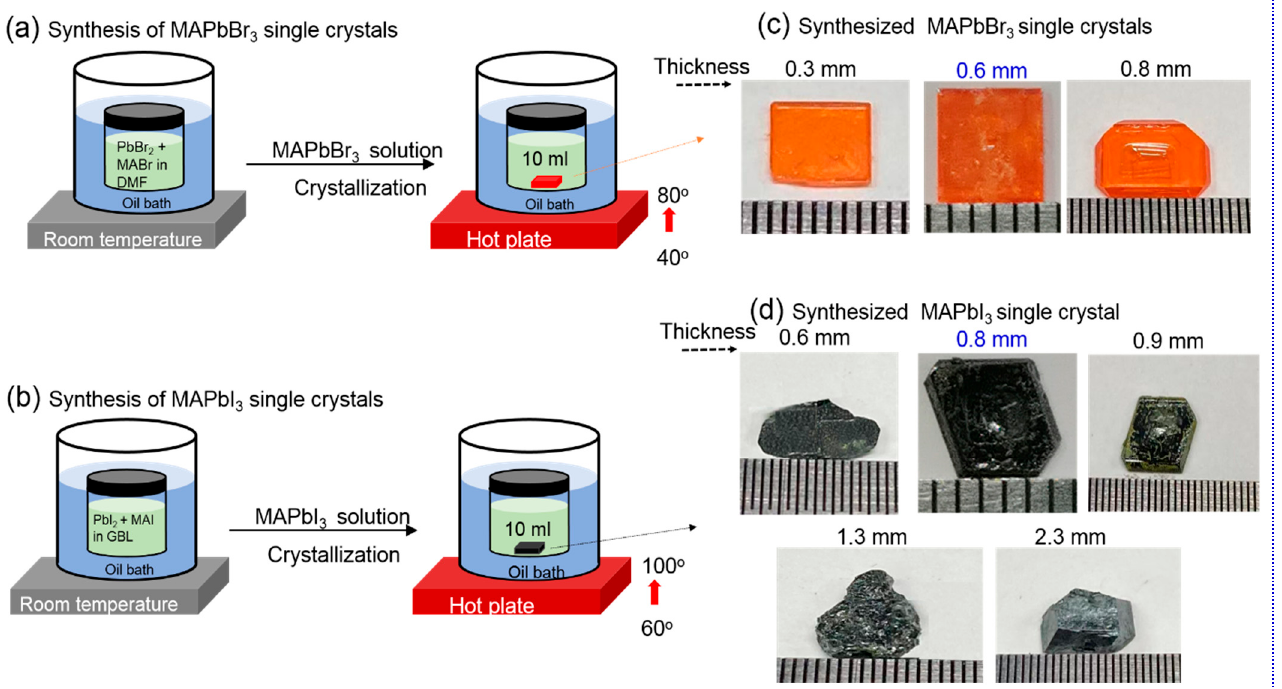
Figure 1. Synthesis schematic of ( a ) MAPbBr 3 and ( b ) MAPbI 3 single crystals using inverse temperature crystallization method. Images of as-synthesized ( c ) 0.3, 0.6, and 0.8 mm MAPbBr 3 single crystals and ( d ) 0.6, 0.8, 0.9, 1.3, and 2.3 mm MAPbI 3 single crystals.